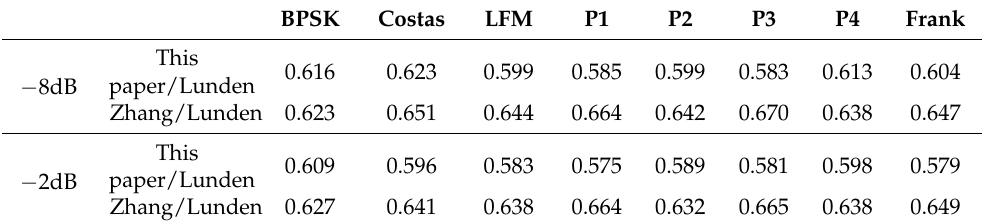
Table 8. The ratio of system’s (this paper and Zhang) time to Lunden’s